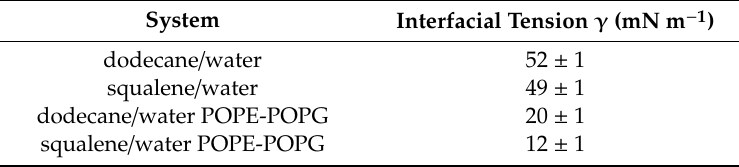
Table 1. Water / oil interfacial tension values. The oil is either dodecane or squalene; the e ff ect of the lipids POPE and POPG at 70:30 mol / mol is also